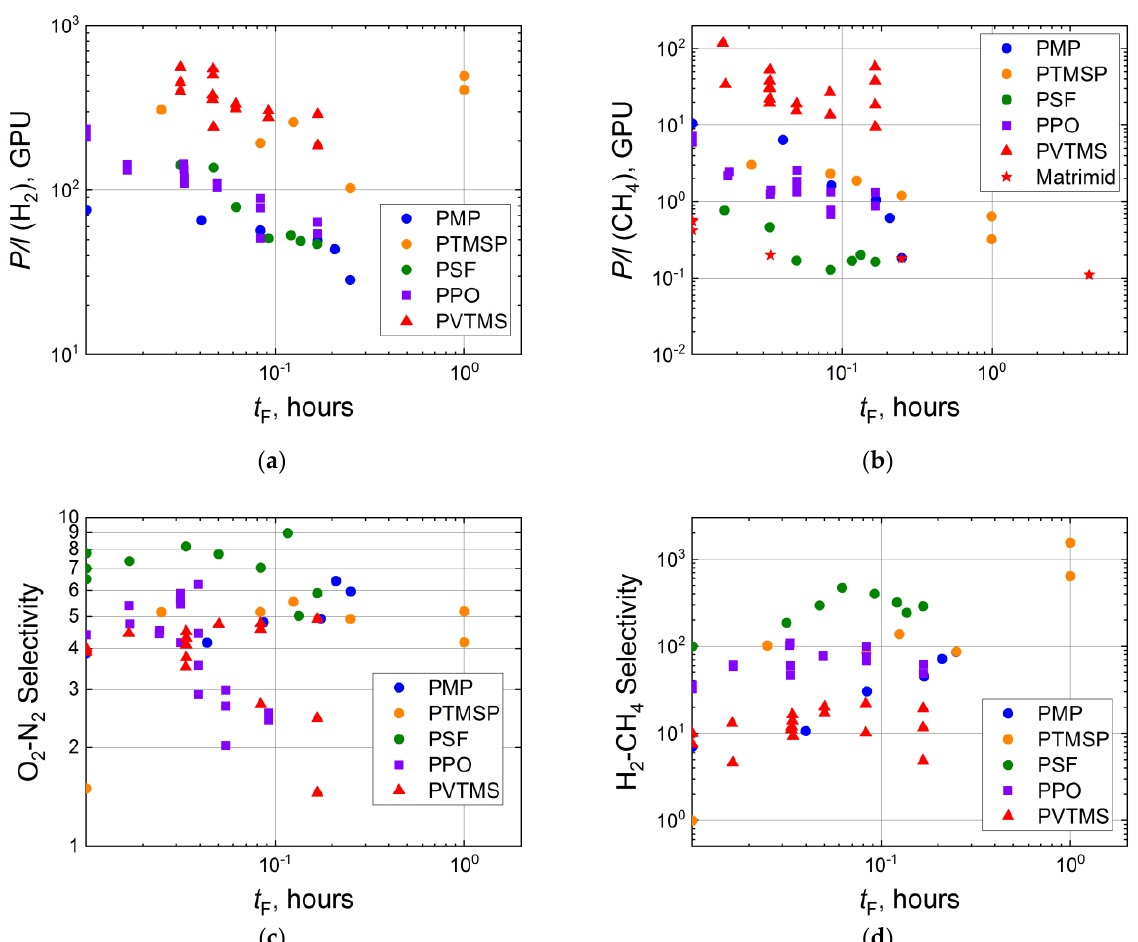
Figure 4. Dependence of H 2 ( a ) and CH 4 ( b ) permeances, ideal selectivities of O 2 -N 2 ( c ) and H 2 -CH 4 ( d ) for the virgin and fluorinated composite membranes (PMP [54], PTMSP [57], PSF [93], PPO [60], PVTMS [94], Matrimid [73]) on duration of the fluorination procedure in logarithmic coordinates.